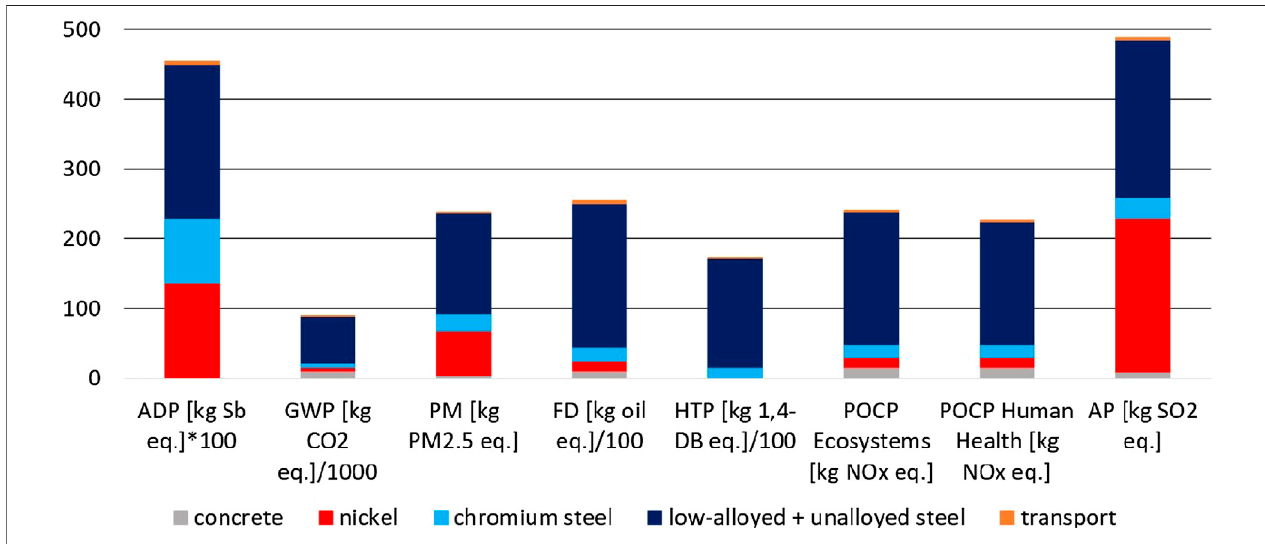
FIGURE 10 | Environmental impacts of the small-scale SMR plant subdivided according to the materials used.